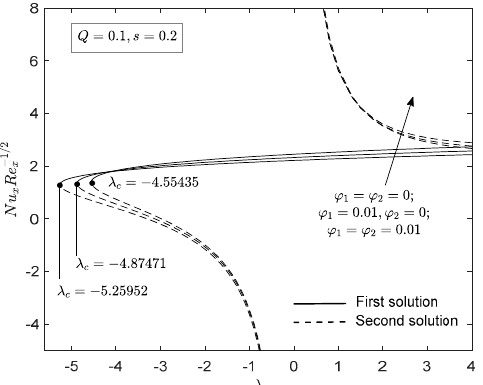
Figure 6. Nu x Re − 1/2 x for different nanoparticles when s = 0.2.